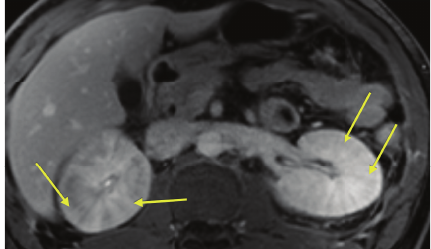
Figure 4: Axial fat-saturated T1w 180 second delayed venous phase contrast enhanced image: there is better conspicuity of the “striated” enhancement pattern (arrows) which is evident in both the renal cortex and the medulla. This finding contrasts with Figure 3 where the “striated” pattern is only evident with the renal cortex.